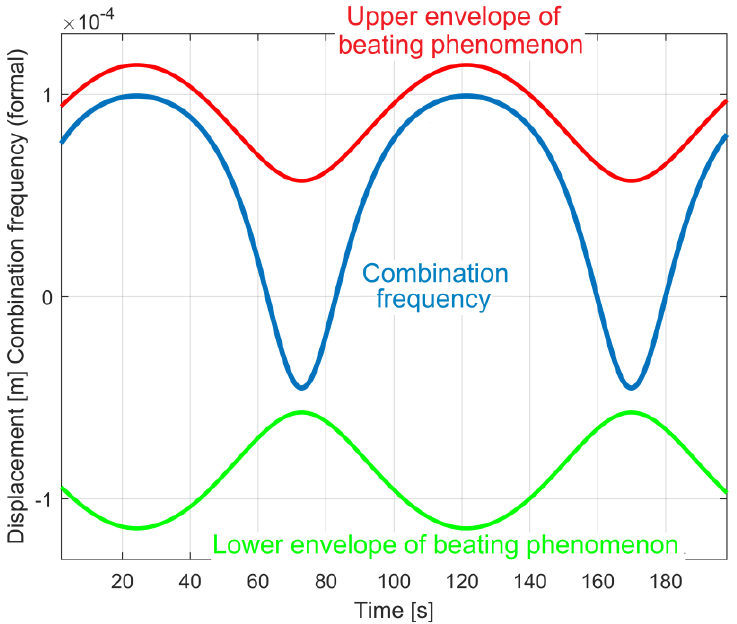
Figure 15. The result of a numerical simulation for the evolutions described in Figure 14.